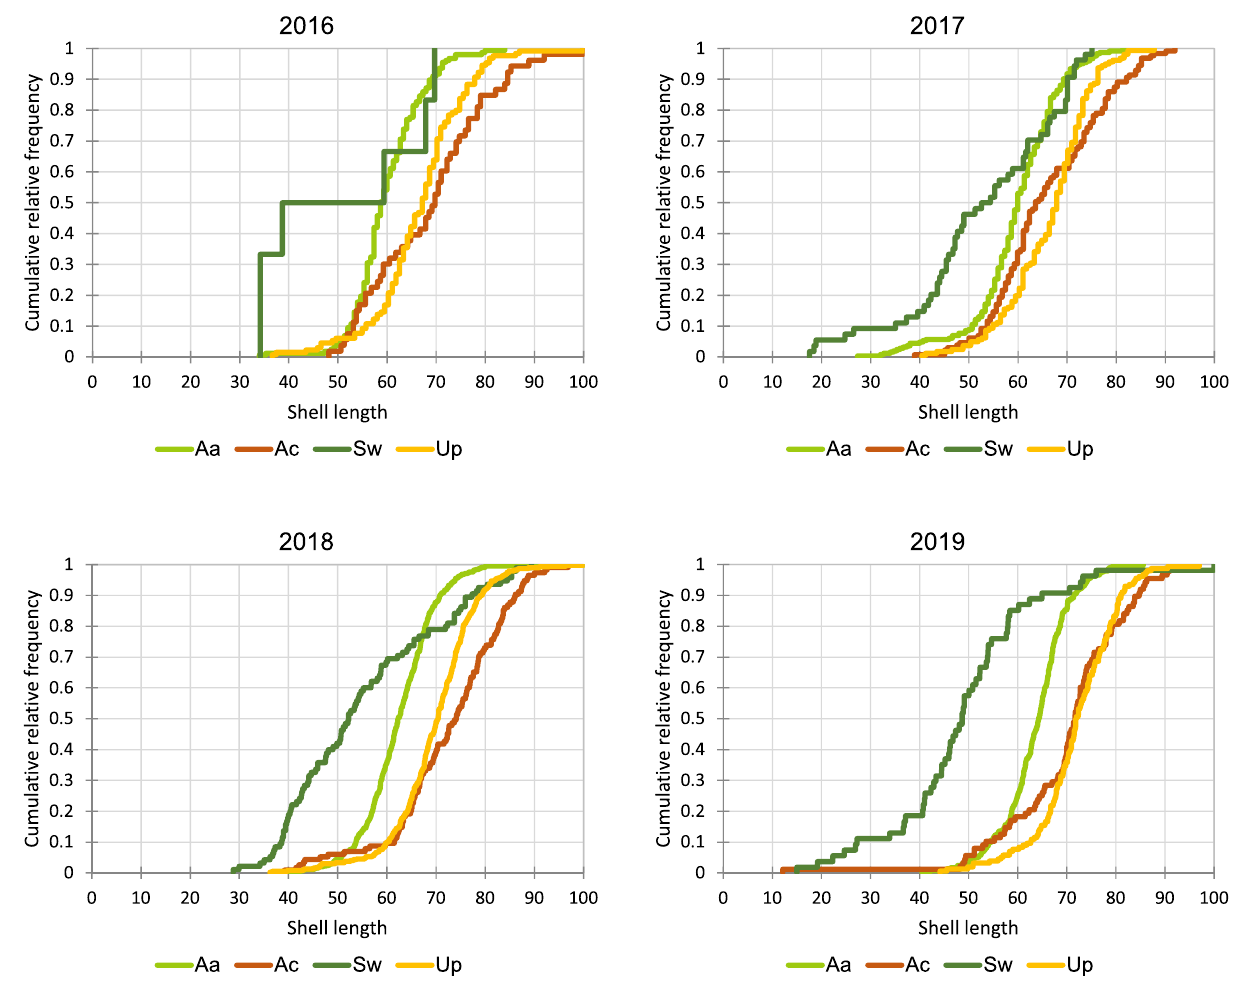
Figure 3. Cumulative shell-length distributions in S. woodiana and co-occurring native mussels in 2016–2019 (measurements min–max normalised). Aa, Anodonta anatina (N 2016 = 157, N 2017 = 245, N 2018 = 448, N 2019 = 294); Ac, A. cygnea (N 2016 = 53, N 2017 = 129, N 2018 = 115, N 2019 = 88); Sw, Sinanodonta woodiana (N 2016 = 6, N 2017 = 54, N 2018 = 95, N 2019 = 54); Up , Unio pictorum (N 2016 = 130, N 2017 = 161, N 2018 = 395, N 2019 =